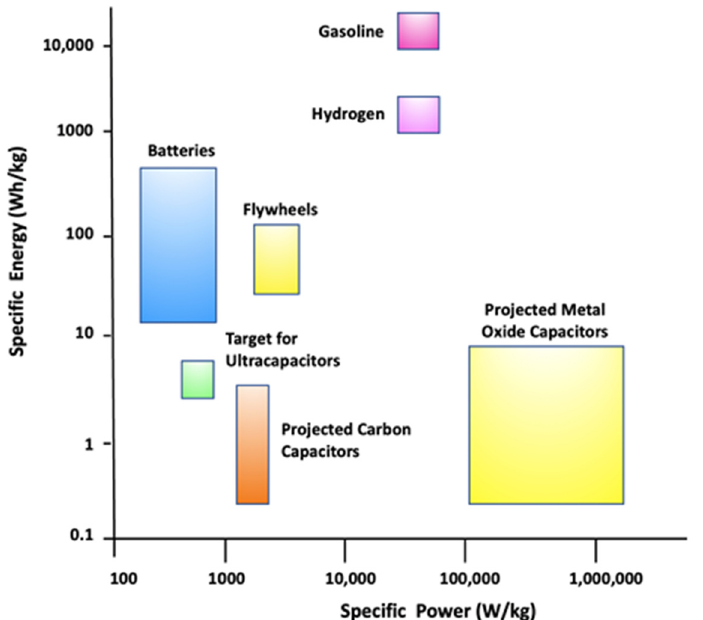
Figure 3. Comparison of specific energy vs. specific power for various energy storage technologies (Adapted with permission from [20]. 2022, Elsevier) .